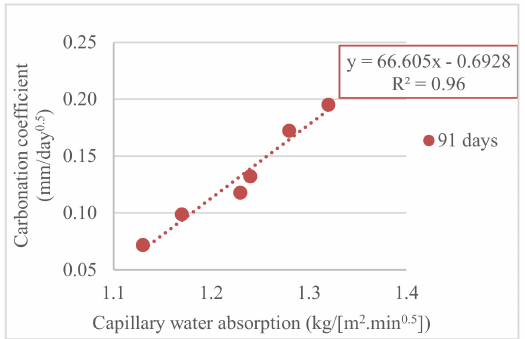
Figure 21. Relationship between the carbonation coe ffi cients and capillary water absorption results at 91 days.